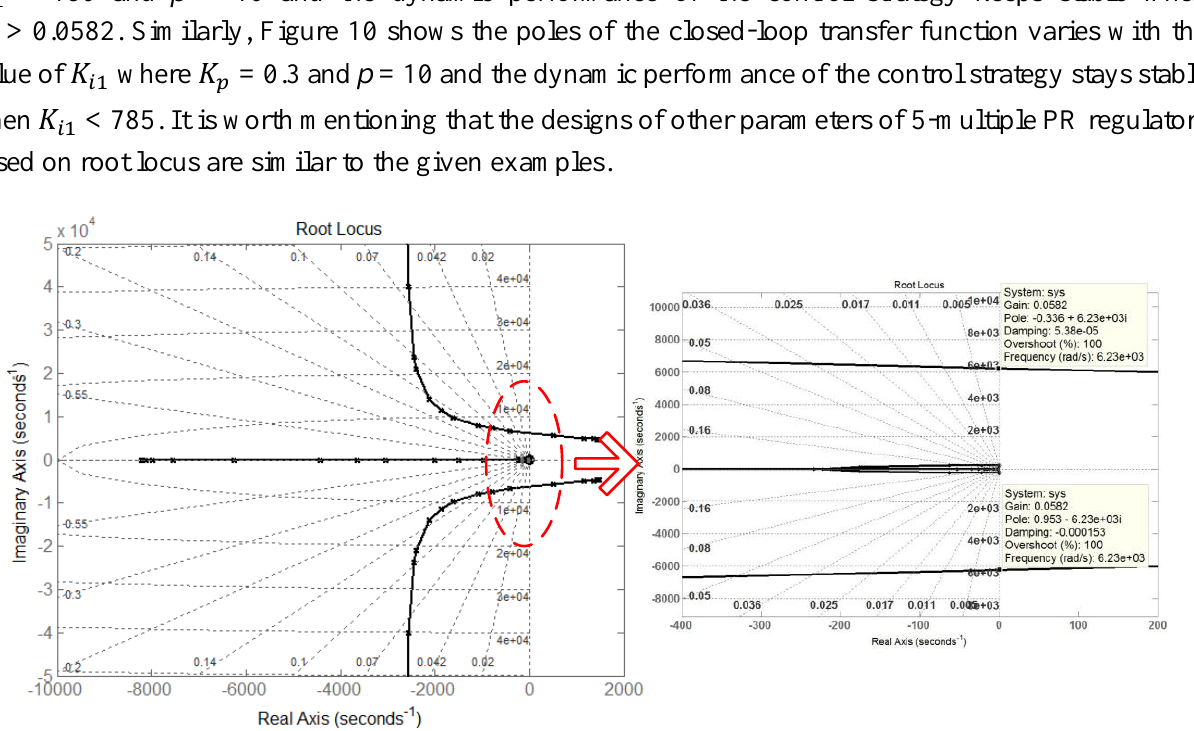
Figure 9. Diagram of root locus with varying parameter 𝐾 maintained